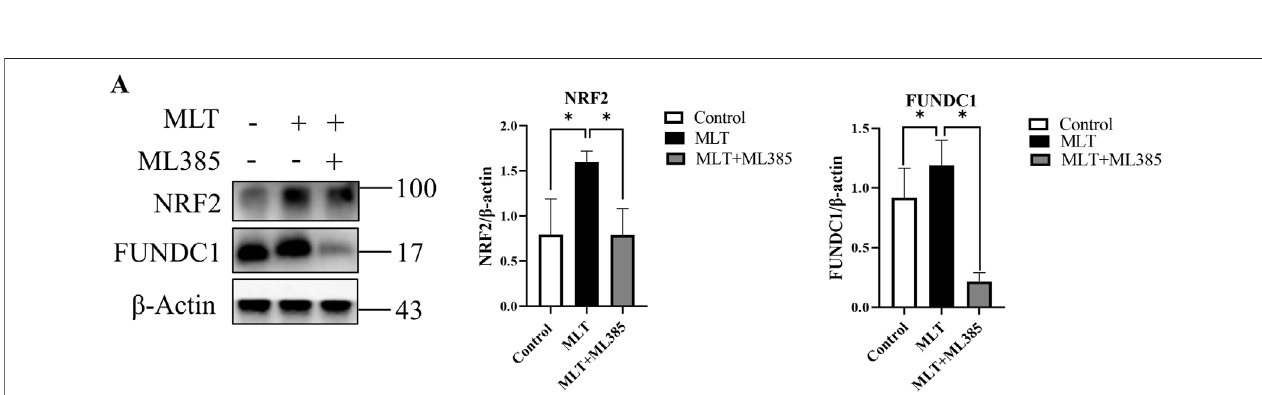
FIGURE 7 | MLT functions through the NRF2/FUNDC1 axis. (A) The mRNA and protein expression levels of NRF2 and FUNDC1 were detected by qPCR and Western blotting, respectively; the expression of NRF2 and FUNDC1 was estimated relative to that of β -actin. * p < 0.05 versus the MLT group.